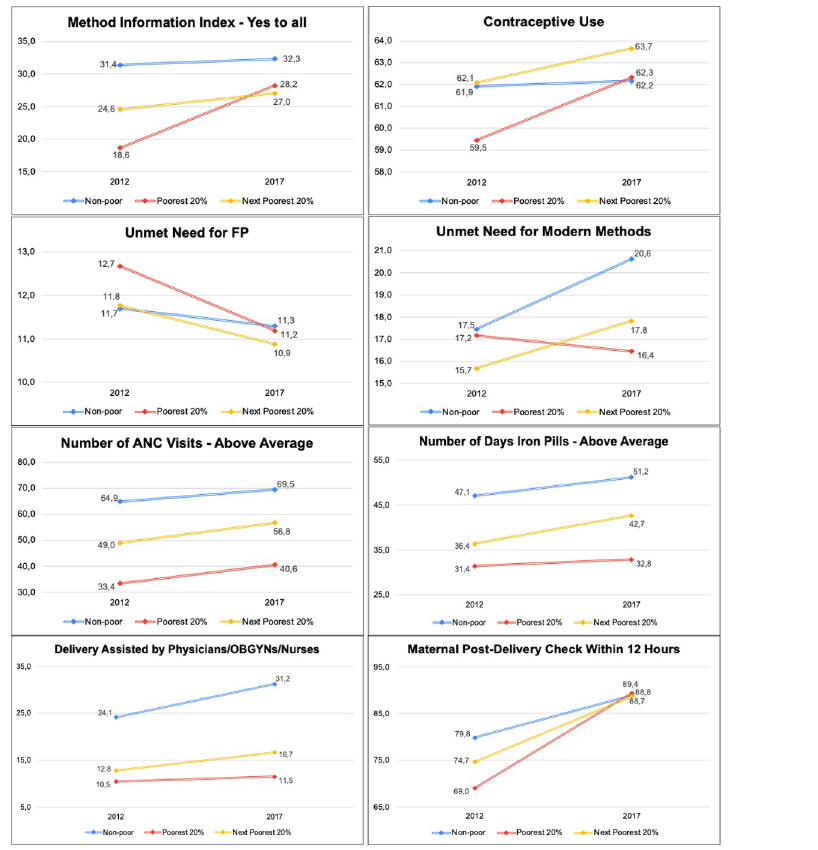
Fig 1. Trends in selected outcomes of family planning and maternal health services,